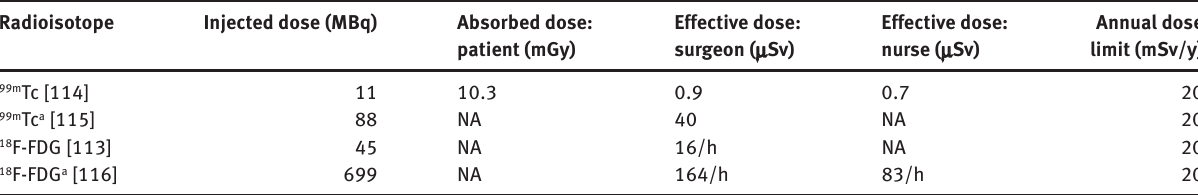
Table 3: Radiation dose associated with 18 F and 99m Tc isotopes during image-guided surgeries. Radioisotope